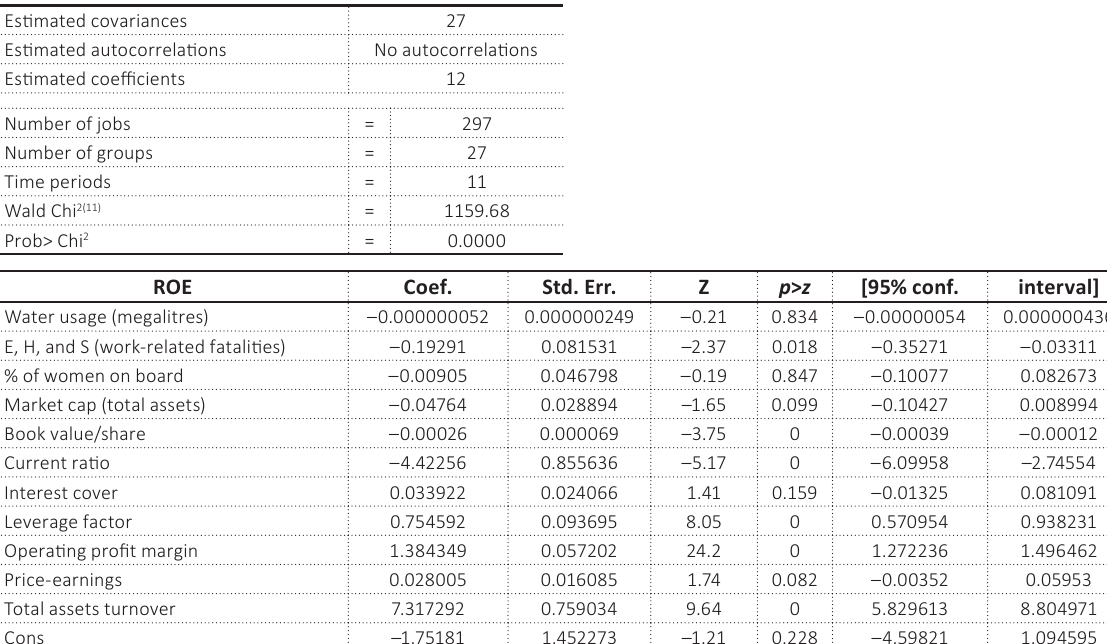
Table 3. Shapiro-Wilk W test for normality